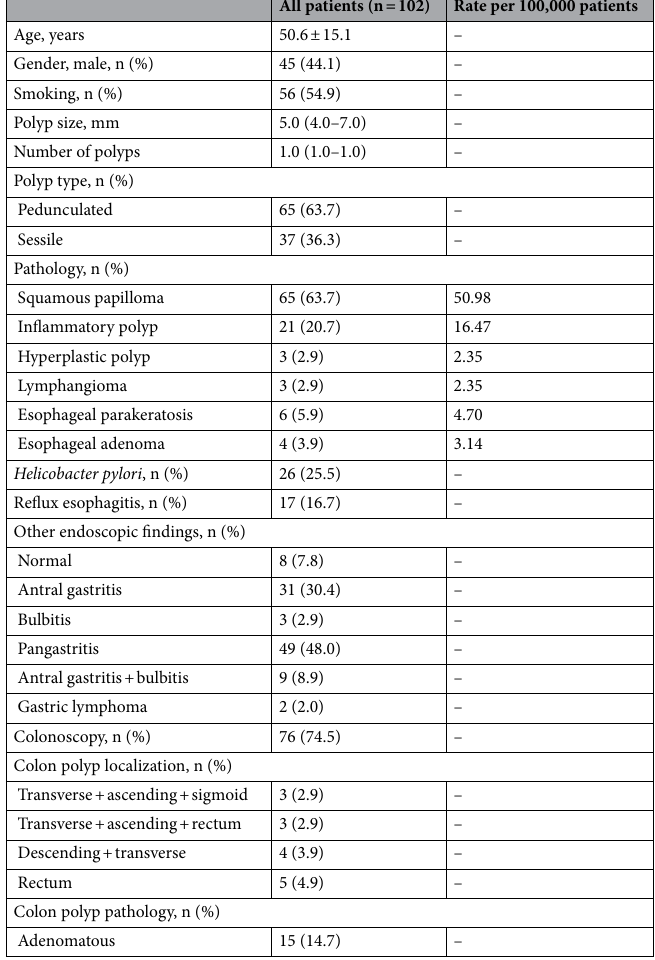
Table 1. Demographic characteristics, endoscopic and colonoscopy findings, and pathological evaluations of patients with esophageal polyps, pathologic findings as rate per 100,000 patients. Data are expressed as median ± SD or median (IQR) or frequency (%). SD standard